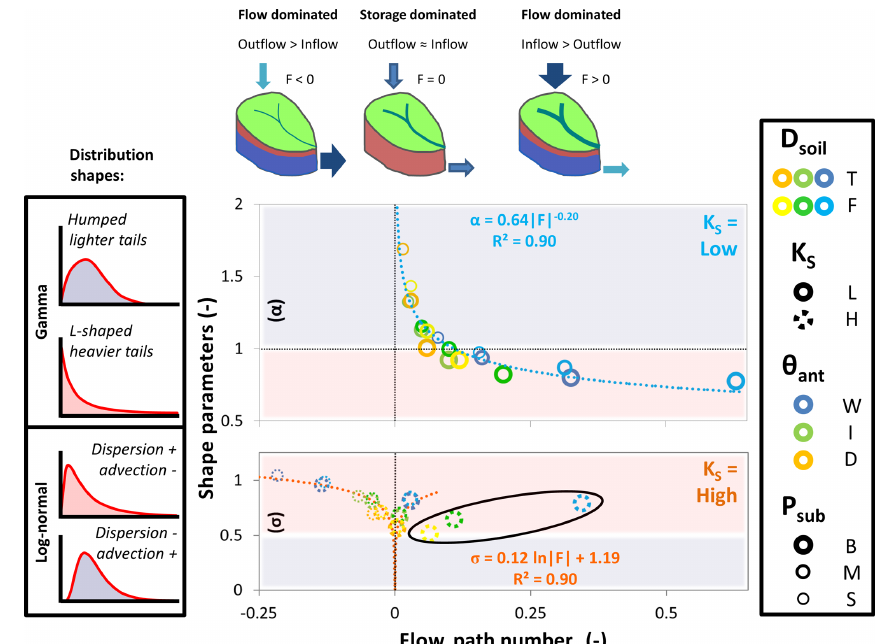
Figure 11. Relationship between the dimensionless flow path number F and the shape parameters α (upper panel, scenarios with low K S ) and σ (lower panel, scenarios with high K S ) of the gamma and the log-normal distribution, respectively. The dotted trend lines are the best-fit regressions for the relationship between the flow path number and the shape parameters α (light blue) and σ (orange). The points in the black circle are excluded from the regression analysis since they are associated with scenarios of excessive surface